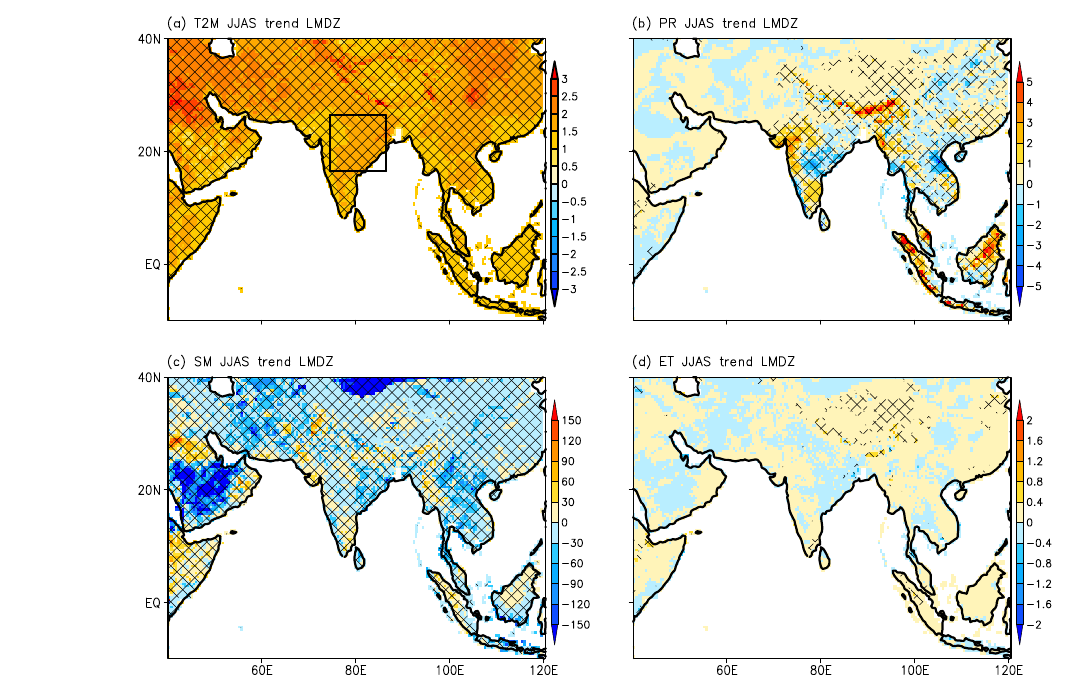
Figure 9. Spatial distribution of linear trends in (a) 2m air temperature ( ◦ C), (b) precipitation (mm d − 1 ), (c) soil moisture (mm) and (d) evapotranspiration (mmd − 1 ) from RCP simulation of LMDZ. Trends are expressed as change over the period 2006–2095. Trend values exceeding the 95% level of statistical significance based on Students t test are hatched. The box indicates central India (74.5–86.5 ◦ E; 16.5–26.5 ◦ N)